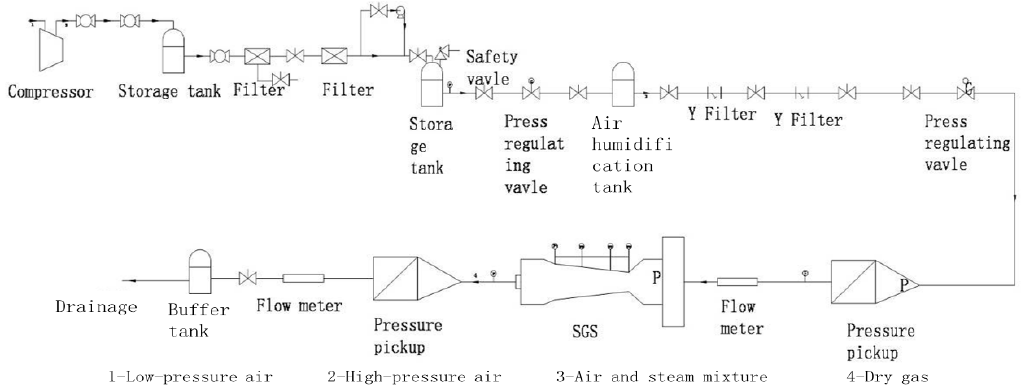
Figure 5. Flowchart of the supersonic condensation process and experimental flow system.